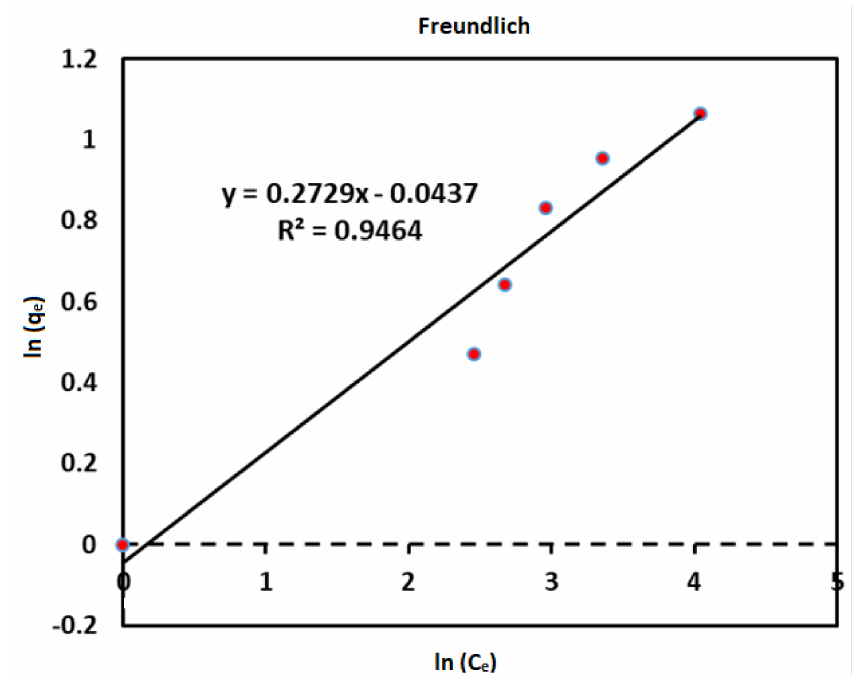
Figure 14. Freundlich isotherm on boron adsorption onto nano-magnetite at pH 8, dosage 0.5 g, contact time 240 min, and initial boron concentration 50